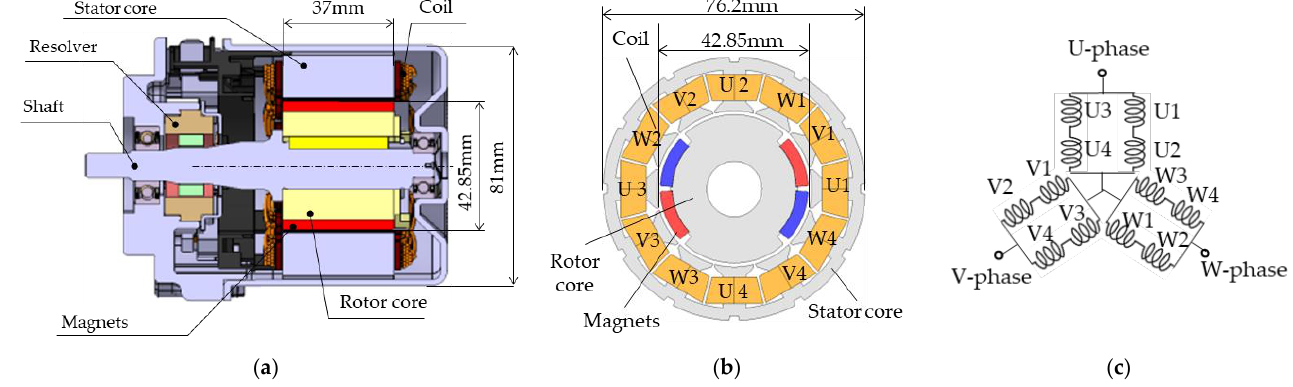
Figure 18. Configuration of prototype motor: ( a ) Cross-section of the prototype motor from the axial direction; ( b ) Cross-section of the prototype motor from the radial direction; ( c ) Winding diagram. Table 2. Specifications of novel consequent-pole prototype motor.